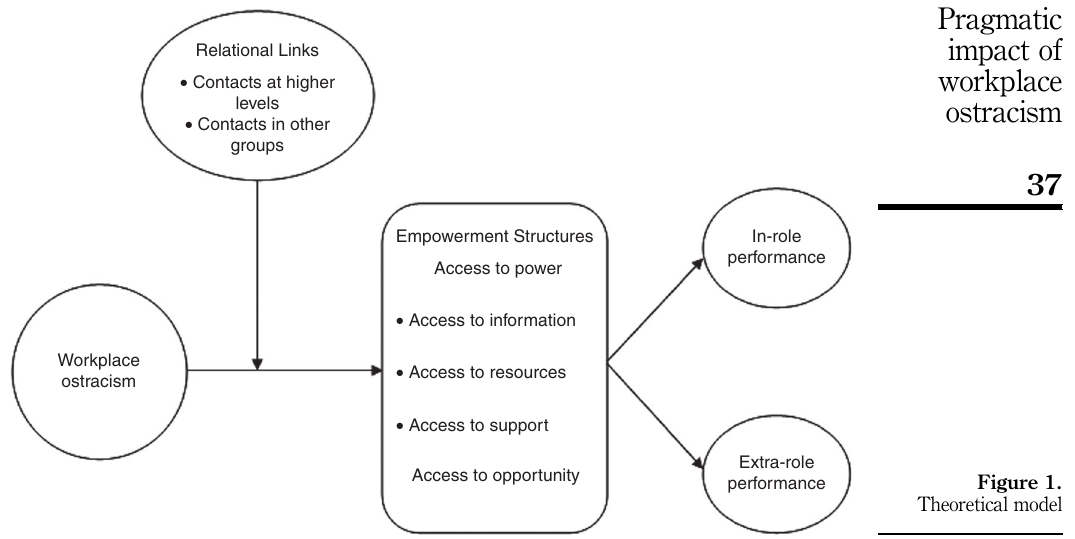
Figure 1. Theoretical